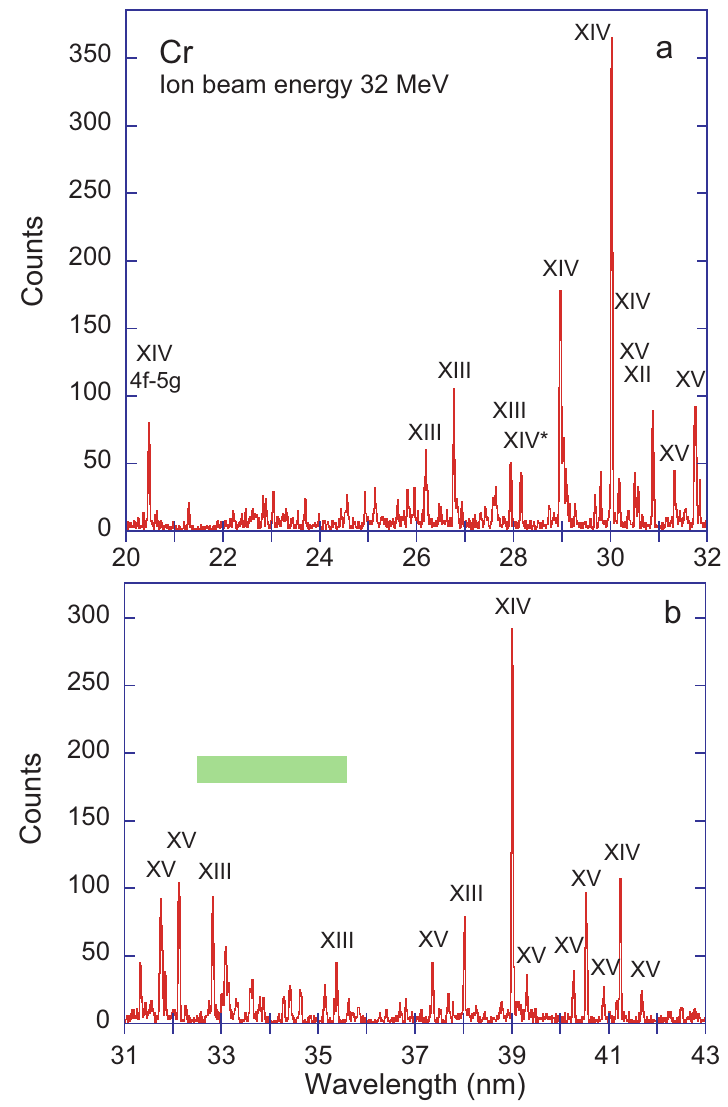
Figure 14. Two sections ( a,b ) of a beam-foil spectra of Cr recorded at an ion beam energy of 32MeV. The strongest lines are identified by the spectrum number. Observation at the foil. Line width (FWHM) 0.035nm. Several spectral features can be identified with yrast transition arrays. The green rectangle in spectrum ( b ) shows the position and range of the detail spectra in Figure